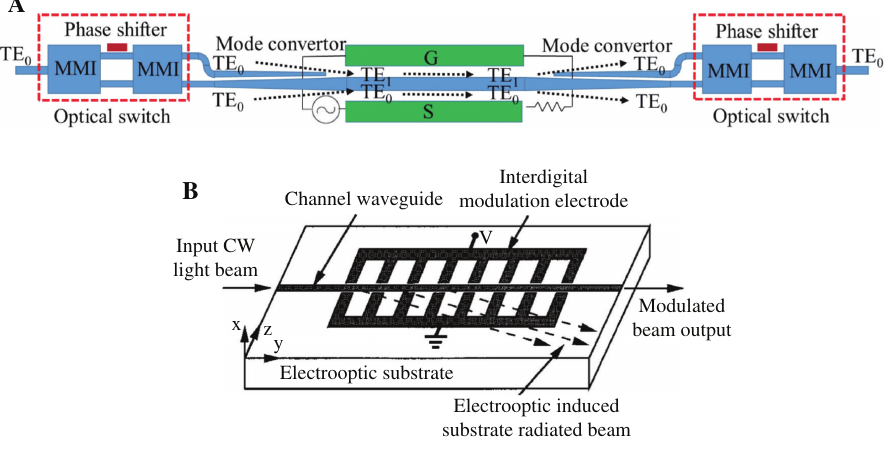
Figure 21: Multimode waveguide modulator and grating coupling modulator. (A) Schematic view of a multimode waveguide modulator. Reprint from Zhou et al. [143], with the permission of the authors. (B) Schematic view of a grating coupling modulator. Reprinted from Wang et al. [144], with the permission of AIP